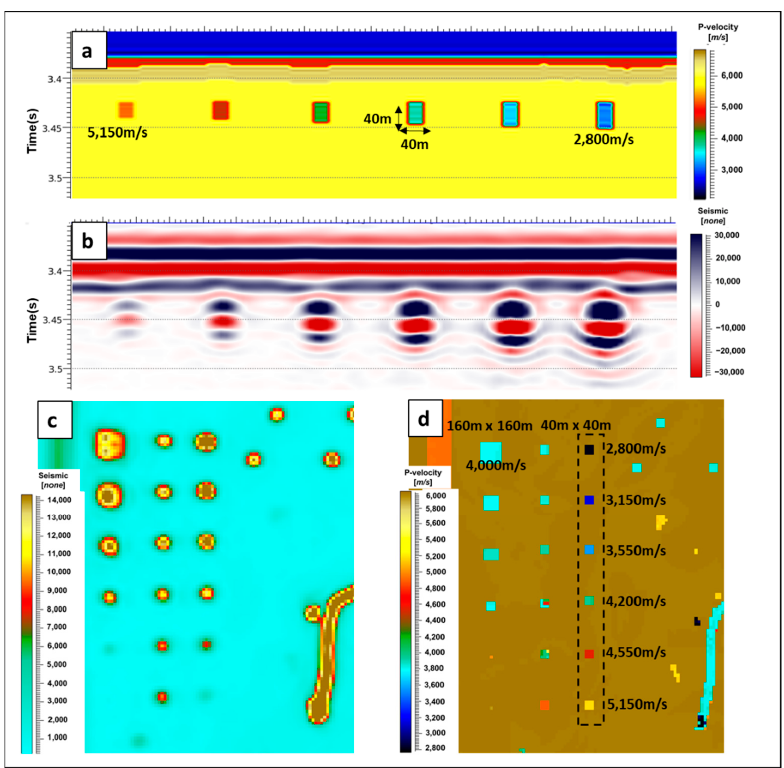
Figure 1. Models of different fillings in the caves. Geological model 1: ( a , d ) geological models; ( b ) seismic model; ( c ) RMS amplitude map. Geological model 2: Different sizes and depths. Differing vertical and horizontal seis-